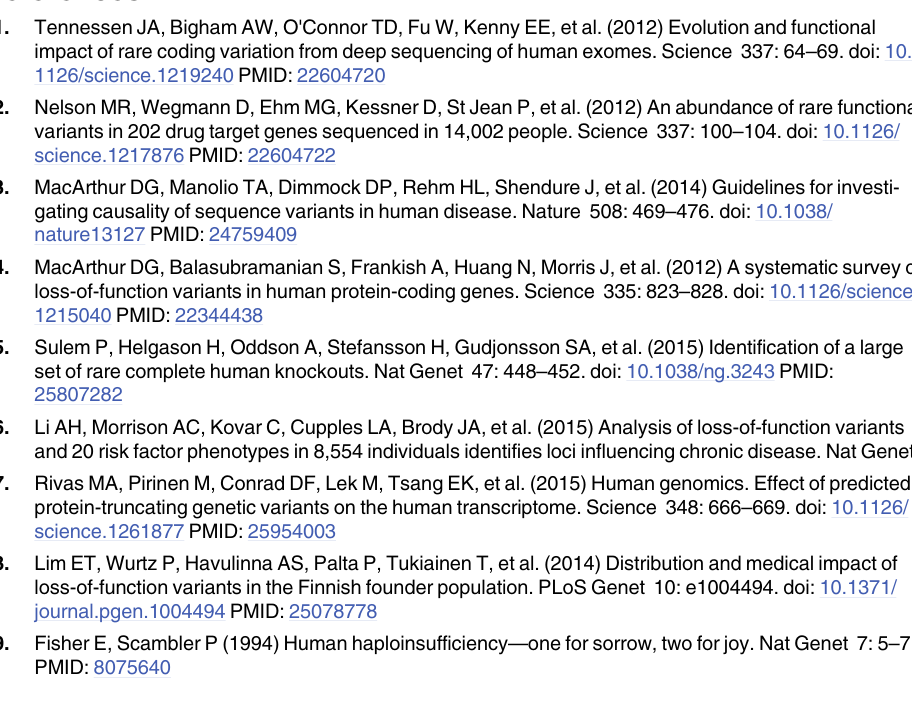
S4 Fig. Distribution of variant counts per gene as observed or predicted under best-fit parameters of model A using 3 different estimation techniques. A: linear space, B: log space. Black curve: observed counts, red curve: prediction based on least-squares fit to the cumulative distribution function (see Methods), green curve: maximum likelihood estimate, blue curve: least squares fit to the accumulation curve of truncated genes as shown in Fig 1. The CDF method was chosen and maximum likelihood was discarded because its estimates did not fit the